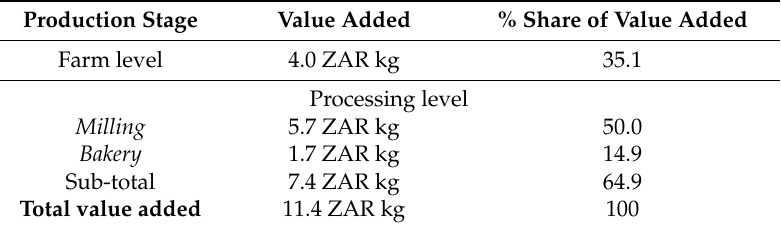
Table 7. Summary of the value added to wheat along the wheat-bread value